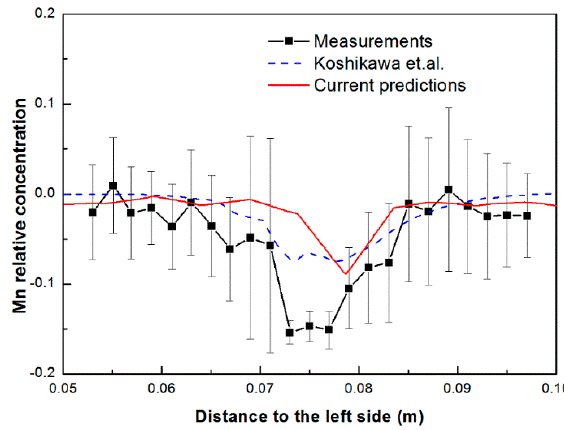
Figure 10. The comparison of the predicted final segregation profile of the ingot with the predictions and measurements presented by Koshikawa et al. [17] at punch height.